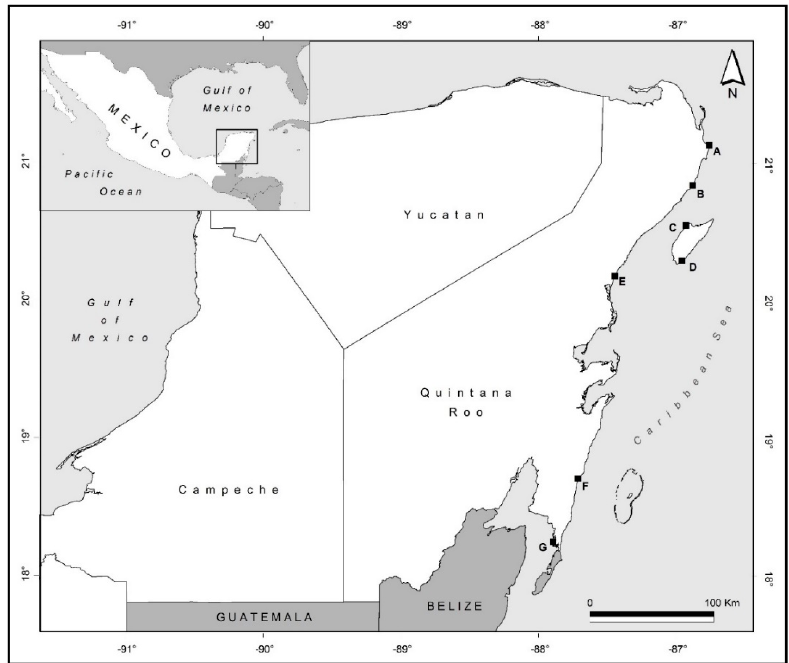
Figure 1. Sampling localities from marine nematodes in the Mexican Caribbean. Site IDs (A, B, C, D, E, F, and G) are explained in Table 1.